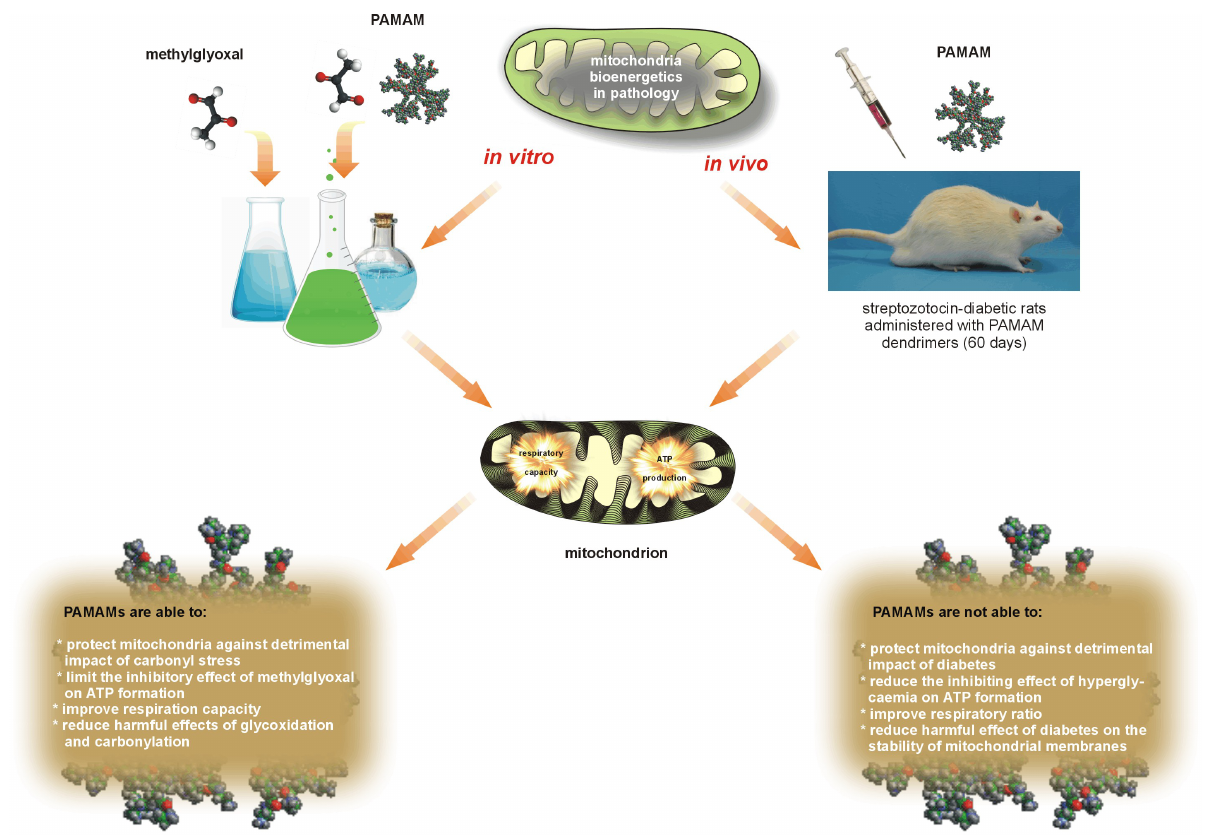
Figure 12. The two faces of PAMAM dendrimers used in restoring the impaired mitochondrial function observed under in vitro and in vivo